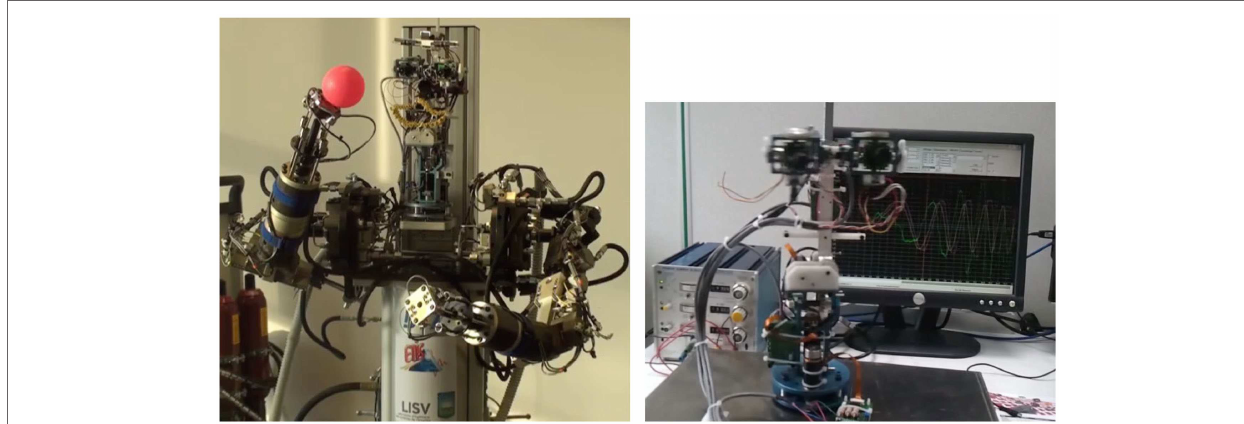
FIGURE 11 | Neck rotation motions of the HYDROïD head mechanism: pitch (A,B), yaw (C,D), and roll (E,F) .